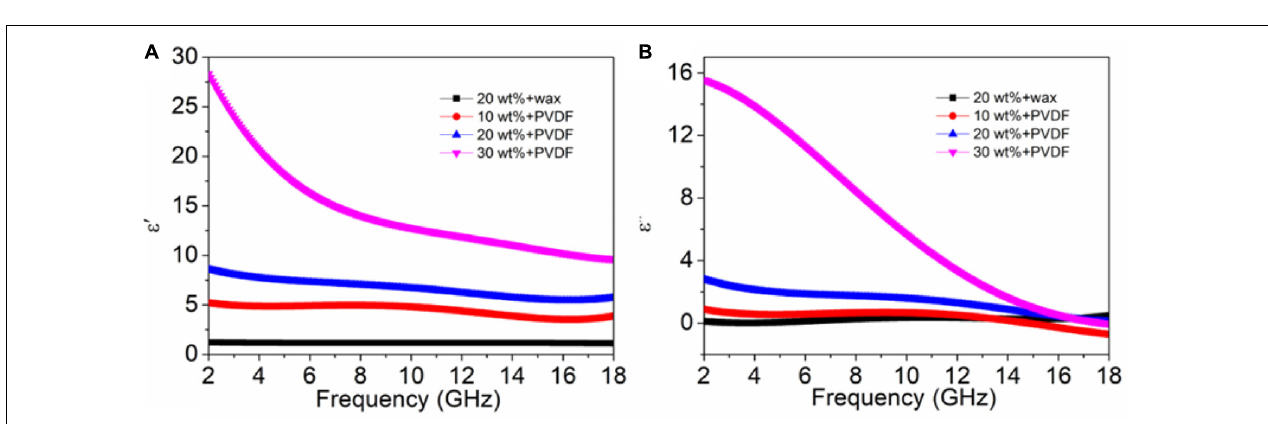
FIGURE 4 | (A) Reflection loss values of four samples at a thickness of 3 mm; (B) reflection loss values at different thicknesses of Ni x S y /PVDF nanocomposites with a filler content of 20 wt%; (C) Ni x S y at a filler content of 10 wt% 3D map of /PVDF nanocomposites; (D) 3D map of Ni x S y /PVDF nanocomposites with a filler content of 30